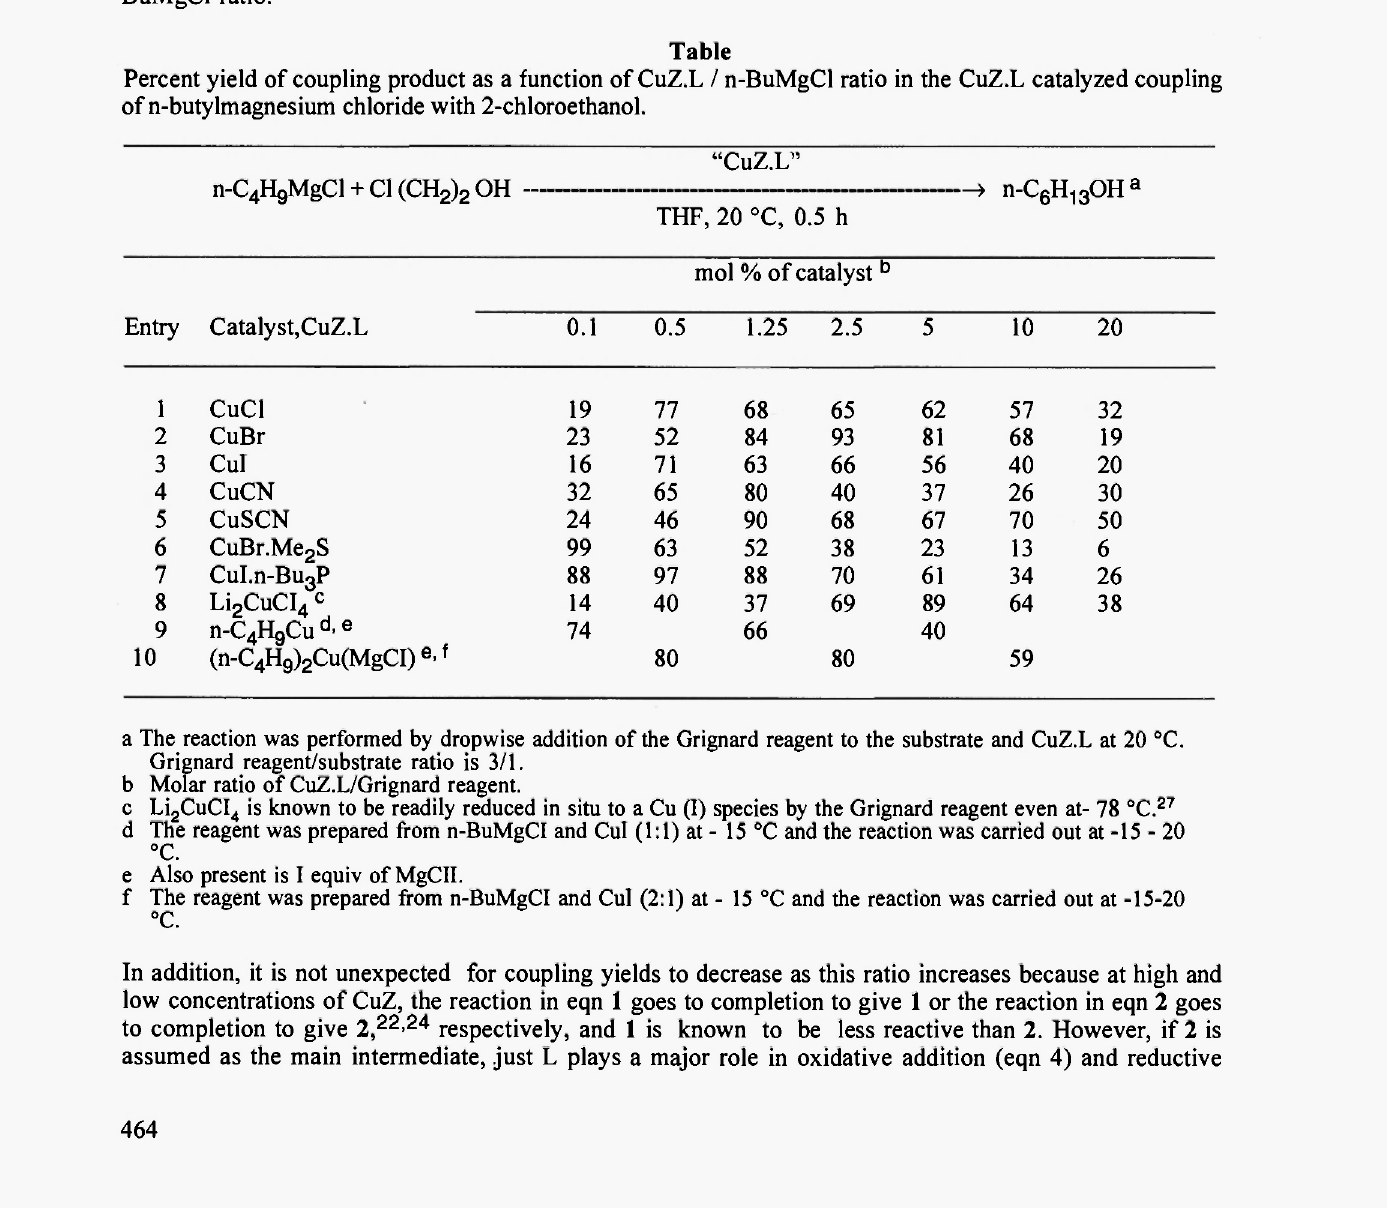
Percent yield of coupling product as a function of CuZ.L / n-BuMgCl ratio in the CuZ.L catalyzed coupling of n-butylmagnesium chloride with